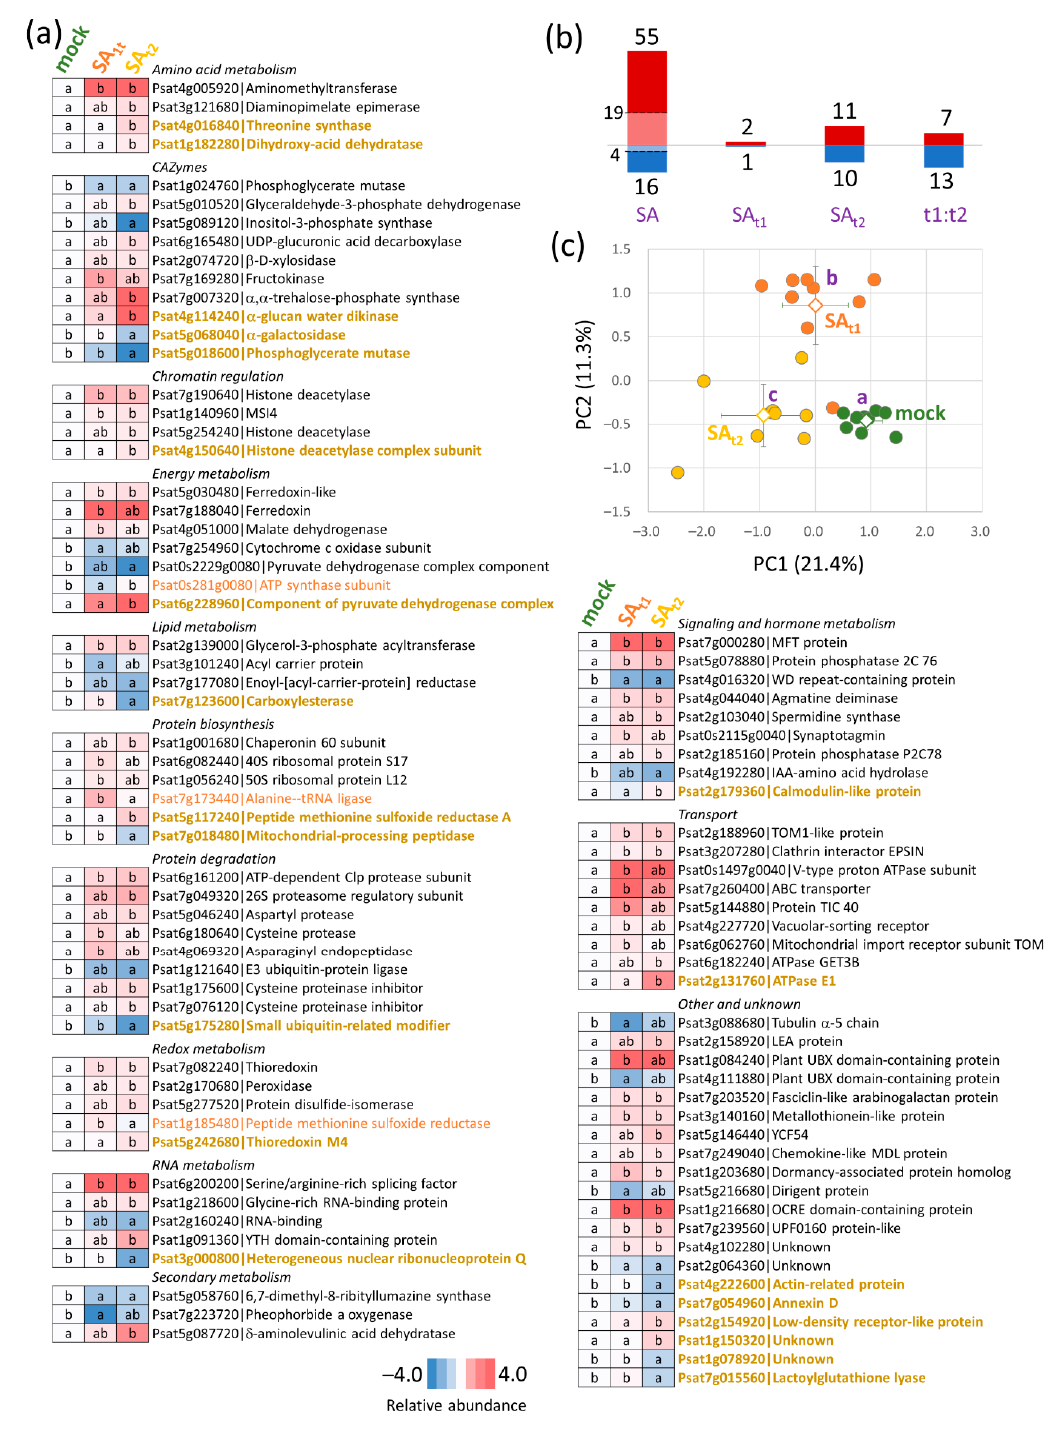
Figure 4. Differentially abundant proteins. ( a ) Heat maps represent the mean relative abundances of nine biological replicates; letters represent the results of Kruskal–Wallis and Conover’s test ( p < 0.05); orange, SA t1 -specific effect; beige, SA t2 -specific effect. ( b ) Summary of the observed effects. SA t1 , SA t1 -specific effect; SA t2 , SA t2 -specific effect; SA, a similar effect in SA t1 and SA t2 seeds, the light shade indicates proteins with statistically significant response in both treatments; t1:t2, significant differences in SA t1 compared to SA t2 . ( c ) PCA based on the profile of all differentially abundant proteins ( p < 0.05, at least 1.4-fold change). Open shapes and dot lines represent means and standard deviations, respectively. The letters represent significant differences (Kruskal–Wallis and Conover’s test, p < 0.05). For details, see Supplementary Table